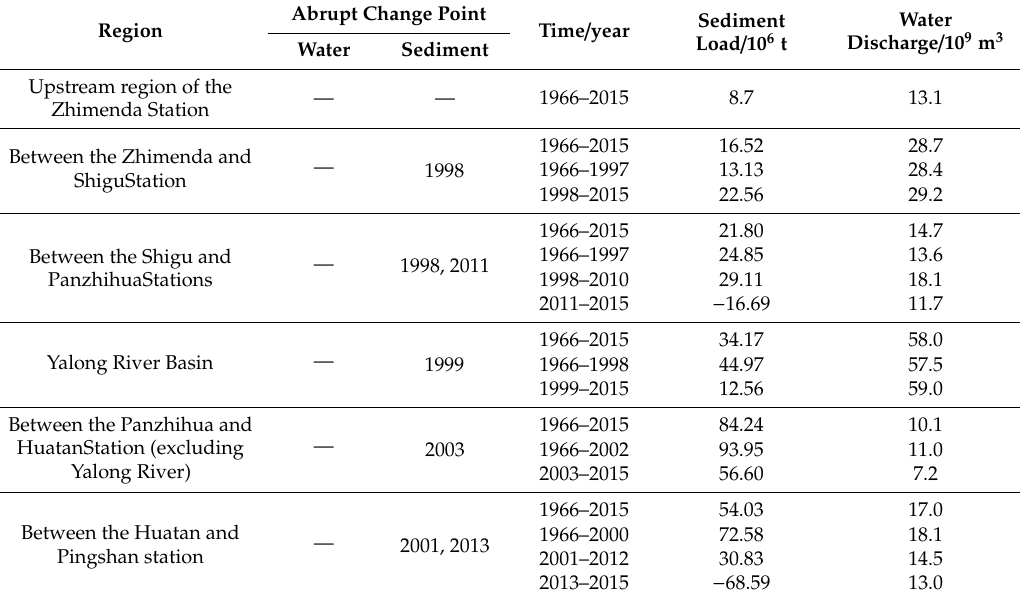
Table 4. Analysis results of water discharge and sediment load in each region at di ff erent periods.